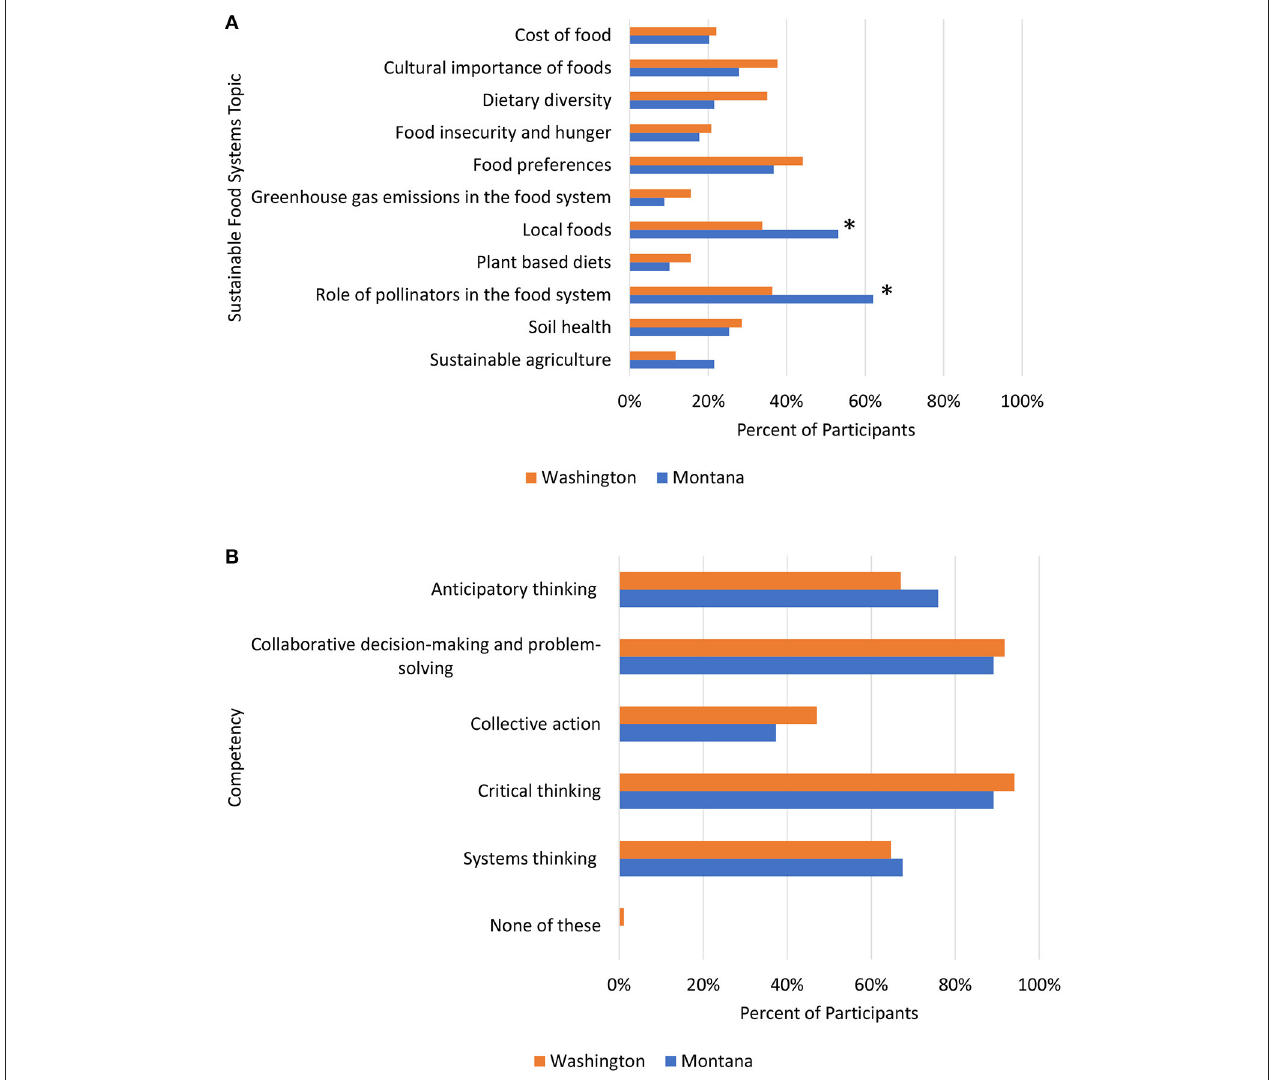
FIGURE 3 | (A) The percent of participants from Washington ( n = 77) and Montana ( n = 79) that report teaching about each food systems content area. (B) The percent of participants from Washington ( n = 85) and Montana ( n = 83) that report striving to foster each competency in their students. Note: Anticipatory thinking was described to teachers as the “ability to understand future impacts of their actions.” Collective action was described to teachers as “using agency to collaborate to solve community problems.” Systems thinking was described to teachers as the “ability to understand that everything is interconnected.” Asterisks represent significant